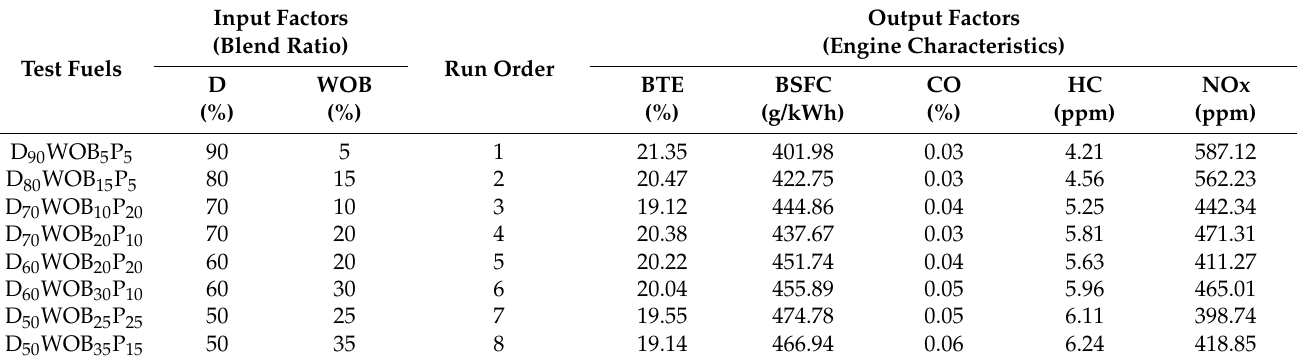
Table 5. DOE matrix and